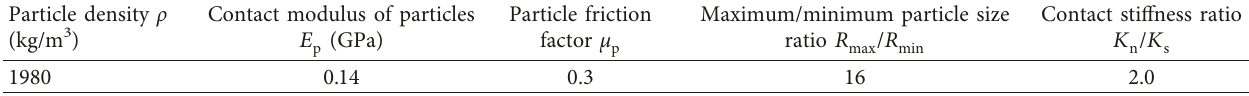
Table 3: Micro parameters of stratum.